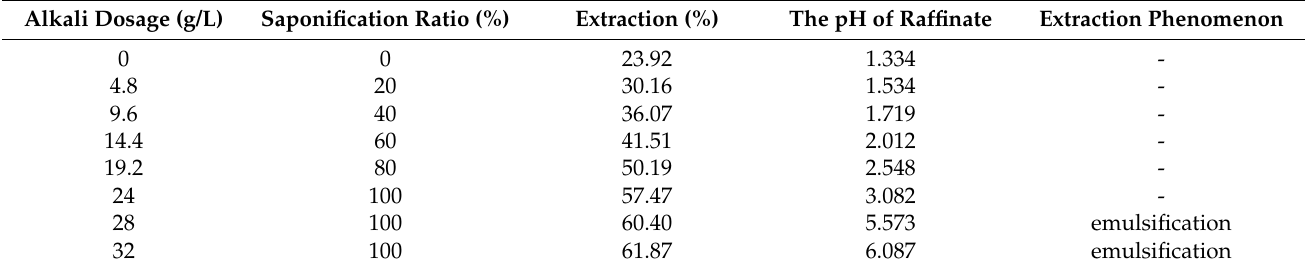
Table 2. The effect of alkali dosage on the saponification of extractant and zinc extraction.